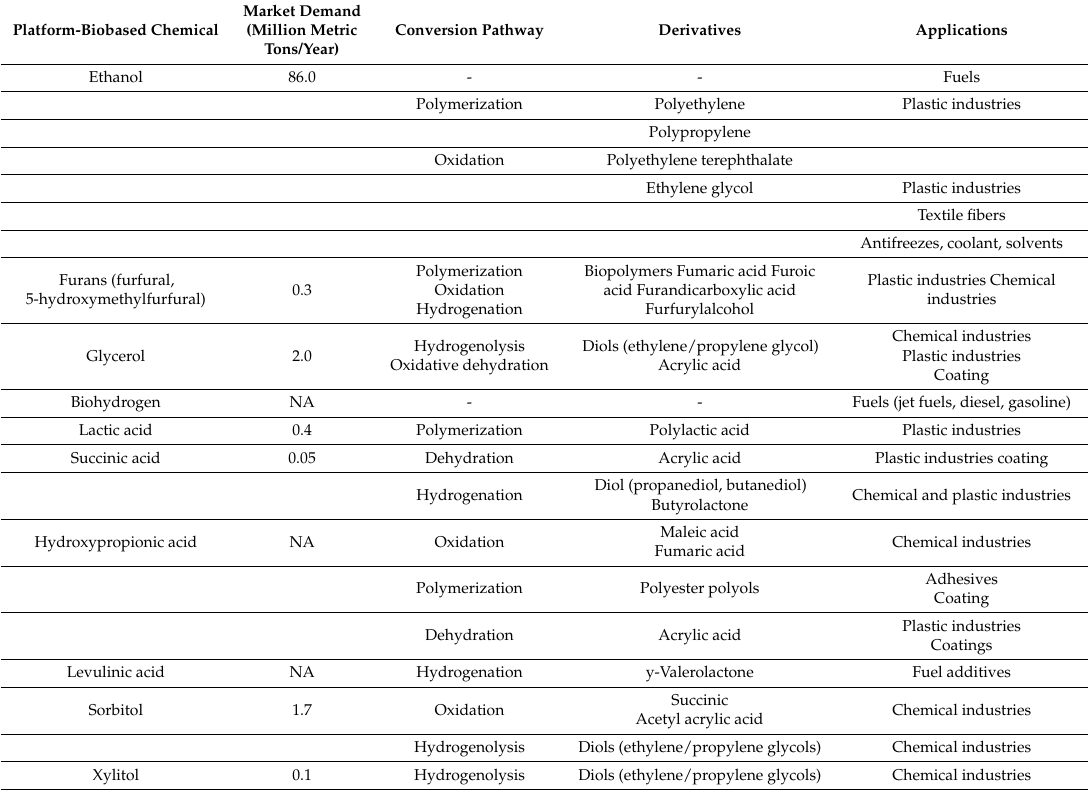
Table 5. Bio-based platform chemicals and derivatives (adapted from